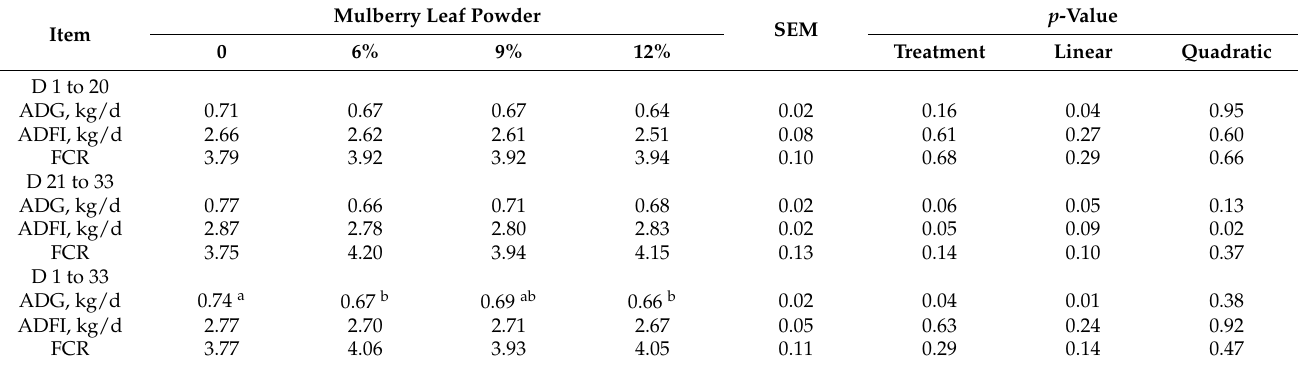
Table 1. Effect of mulberry leaf powder of varying levels on growth performance in finishing pigs.